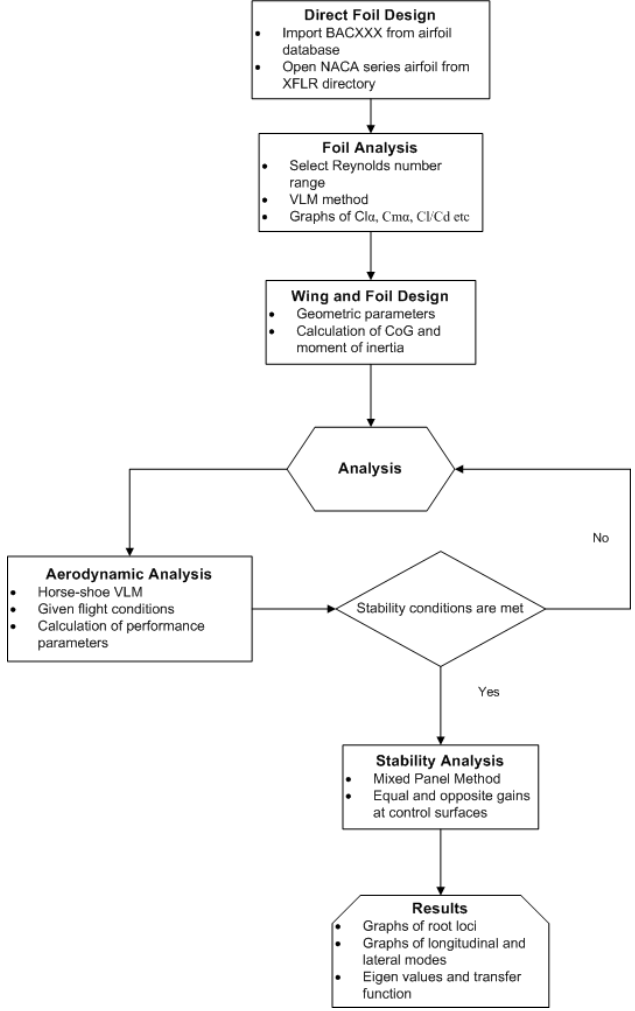
Figure 9. The XFLR methodology—the roadmap to designing and analyzing an aircraft using XFLR